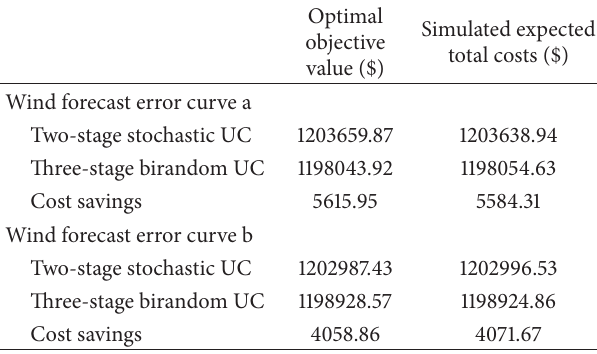
Table 8: Simulation results with different wind power forecast error